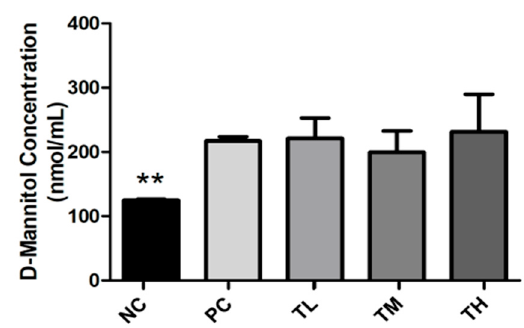
Figure 9. Effect of IMD on D-mannitol concentration in the plasma of mice with LPS-induced chronic inflammation, as measured by colorimetric assay. Results are expressed as means ± SEM of n = 2 samples for NC and PC, and n = 3 samples for TL, TM, and TH. Differences in means were considered statistically significant for ** p < 0.01 relative to PC.